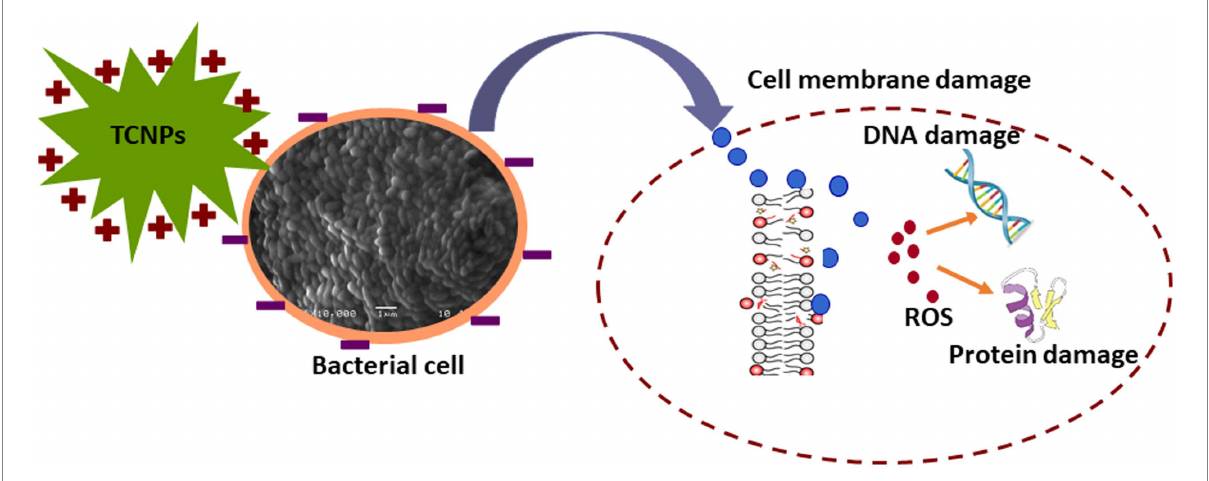
FIGURE 7 Schematic representation of TCNPs leading membrane disruption and a synergy of action leading to induction of